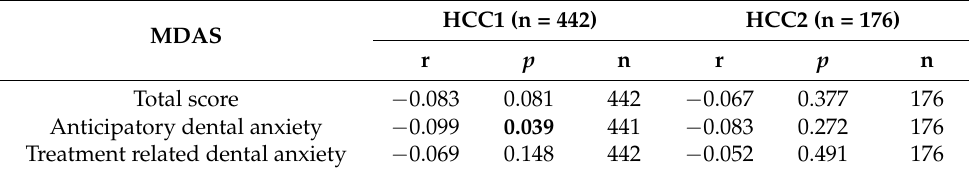
Table 3. Pearson correlation coefficients between dental anxiety (ln-transformed MDAS total score) and its factors, anticipatory dental anxiety and treatment-related dental anxiety, and ln- transformed HCC. HCC1 (n = 442) HCC2 (n = 176) MDAS r p n r p n Total score − 0.083 0.081 442 − 0.067 0.377 176 Anticipatory dental anxiety − 0.099 0.039 441 − 0.083 0.272 176 Treatment related dental anxiety − 0.069 0.148 442 − 0.052 0.491 176